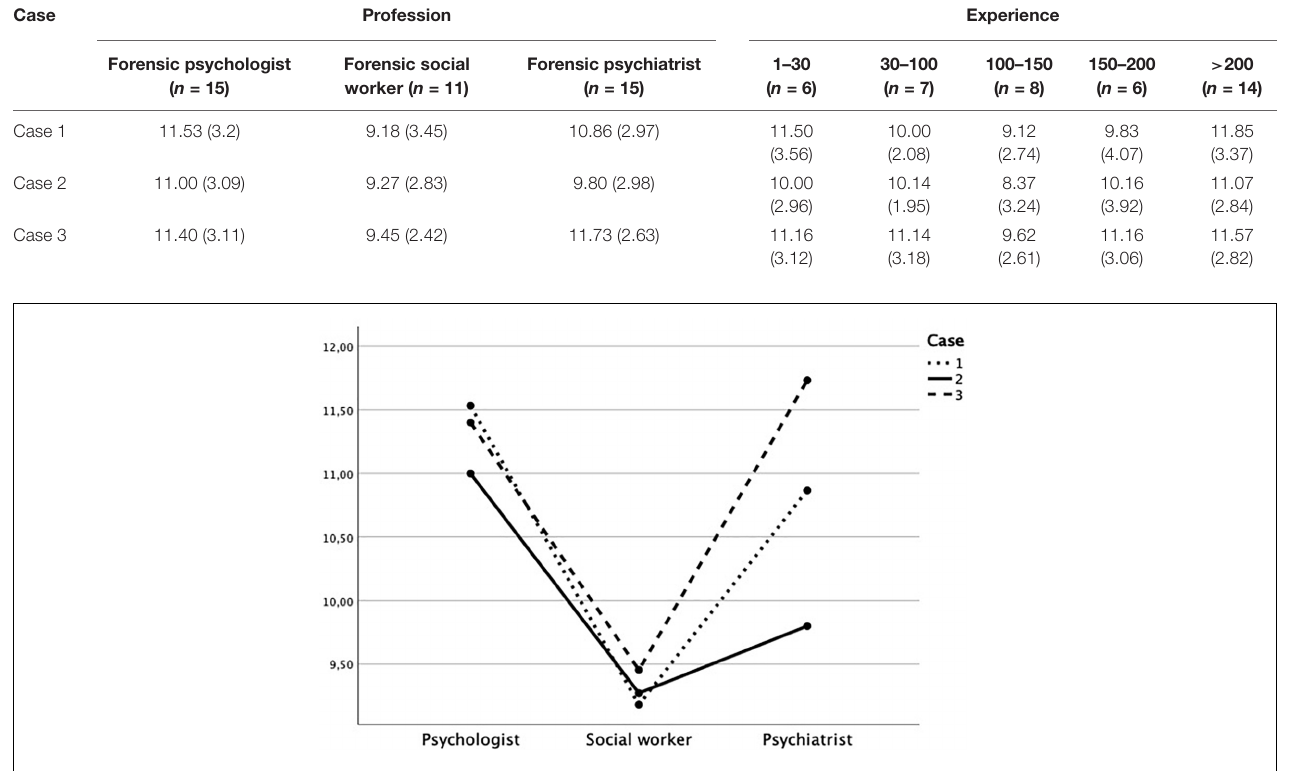
FIGURE 3 | Mean values of information sources requested by each profession in each case.